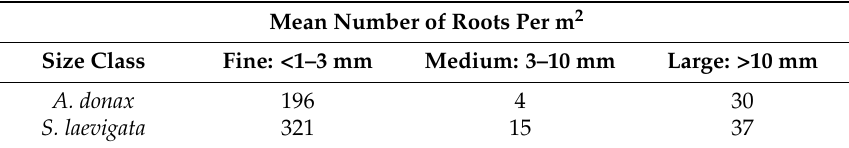
Table 9. Mean number of fine, medium and large roots per m 2 for A. donax and S. laevigata.